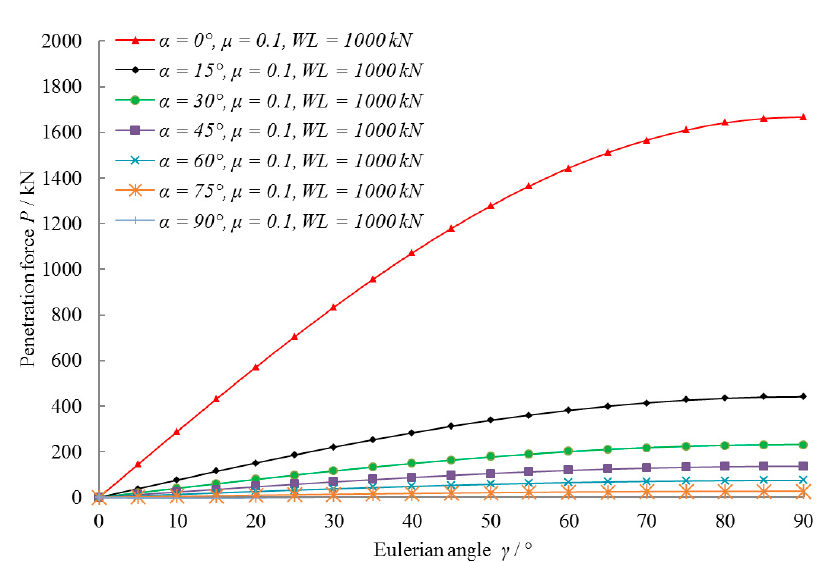
Figure 15. Relationship between the penetration force P and Eulerian angle γ .